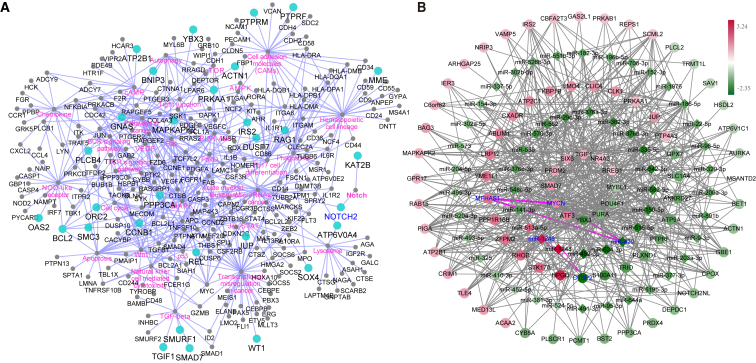
The Regulatory Network and Crosstalk Analysis for Gene Set(A) KEGG pathway network formed by relapse gene sets. Blue nodes, DEGs; pink labels, KEGG pathways. (B) miRNA-TF-gene regulatory network for DEGs in remission gene sets. Hexagon, miRNA; diamond, transcriptional factor; ellipse, gene.